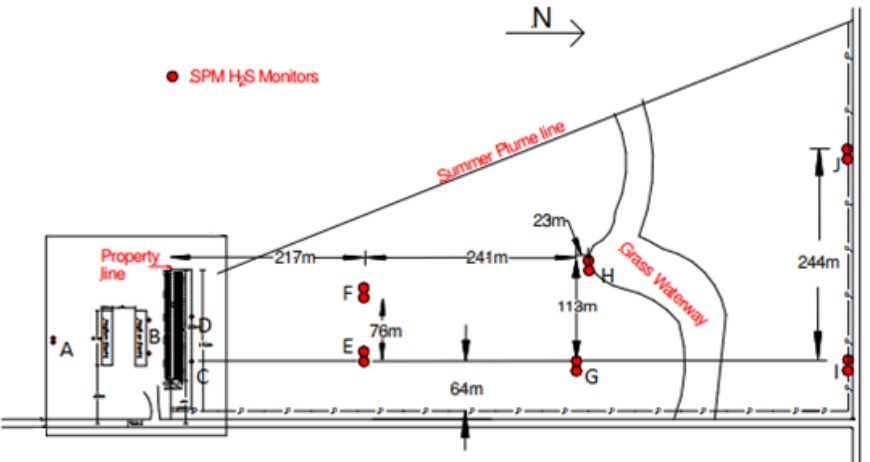
Figure 2. Monitoring locations around a swine facility for the swine case study (adapted from Hofer, 2009). Point B is next to the barn. The shelterbelts were planted on the property line between monitoring location B and D, but the data used in case study 2 were collected before the trees were